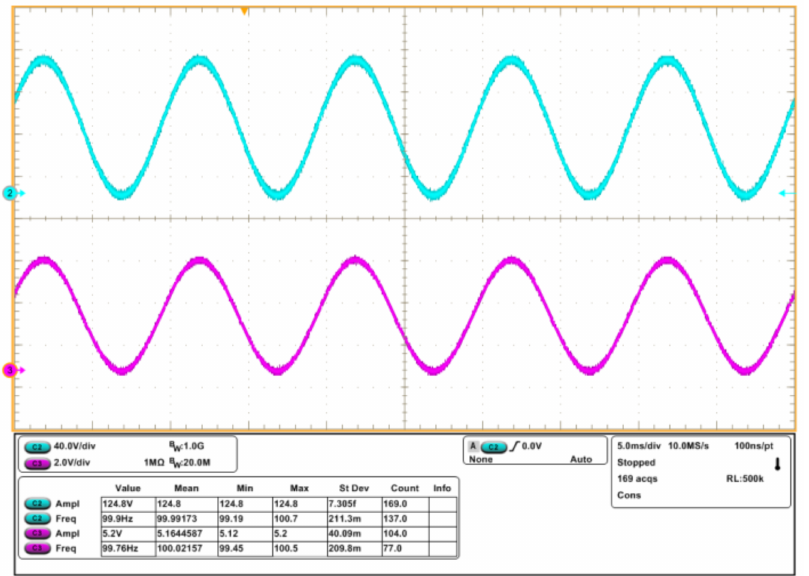
Figure 17. Measured sinusoidal input–output waveforms for the power amplifier using high-voltage operational